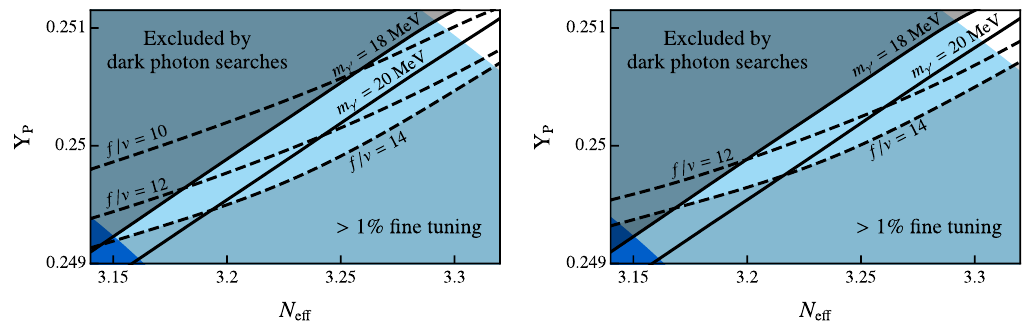
Figure 3 . Contours of constant m (cid:13) 0 (solid) and f=v (dashed) on the N e(cid:11) - Y P plane assuming m f 0 = 80 (left) and 30 (right) GeV for non-top, charged twin fermions. The dark and light blue regions are respectively the 1 (cid:27) and 2 (cid:27) containment from Planck [32]. They combine the Planck TT, TE, and EE+lowE+lensing+BAO data with the Y P bounds from [72]. Twin photons lighter than 18 MeV are constrained by experiments and f=v & 14 requires (cid:12)ne-tuning greater than